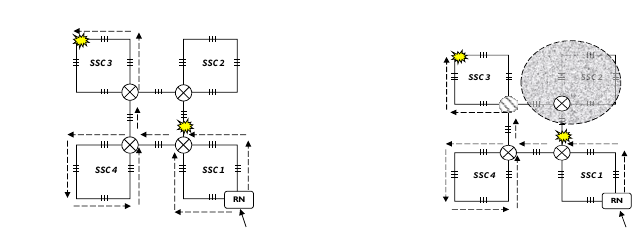
Figure 12. Unrecoverable FBGs in case